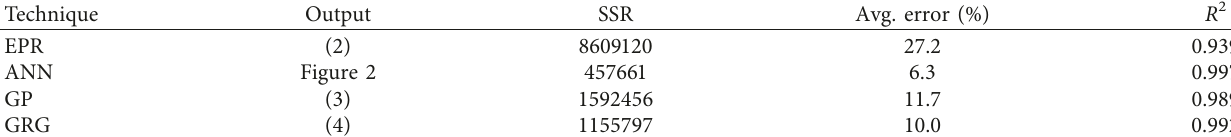
Table 5: Accuracies of developed